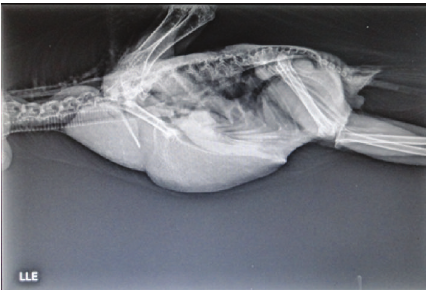
Figure 1: Radiographic image showing enlarged kidney and mildly dilated crop.